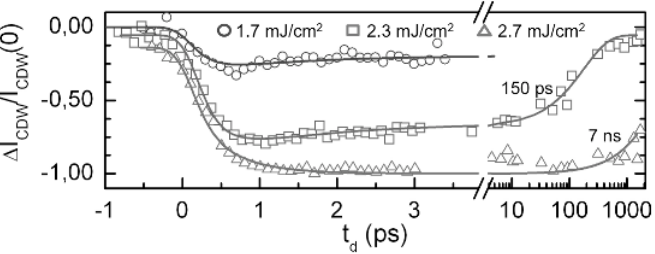
Fig. 2. CDW dynamics in the initial photoinduced suppression and the long recovery period, displayed for 3 different fluences. In the pertubative regime below 2.5 mJ/cm 2 , the CDW recovery in the T layers of 4H B -TaSe 2 is strongly hindered by the shielding H layers, expressed by the long time constant of 150